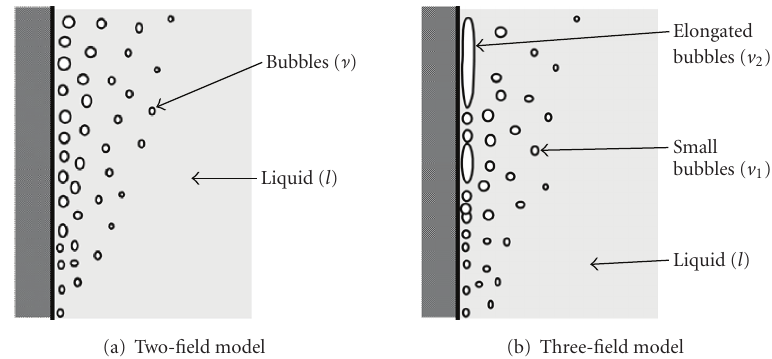
Figure 1: An illustration of the multifield model of two-phase flow in a boiling